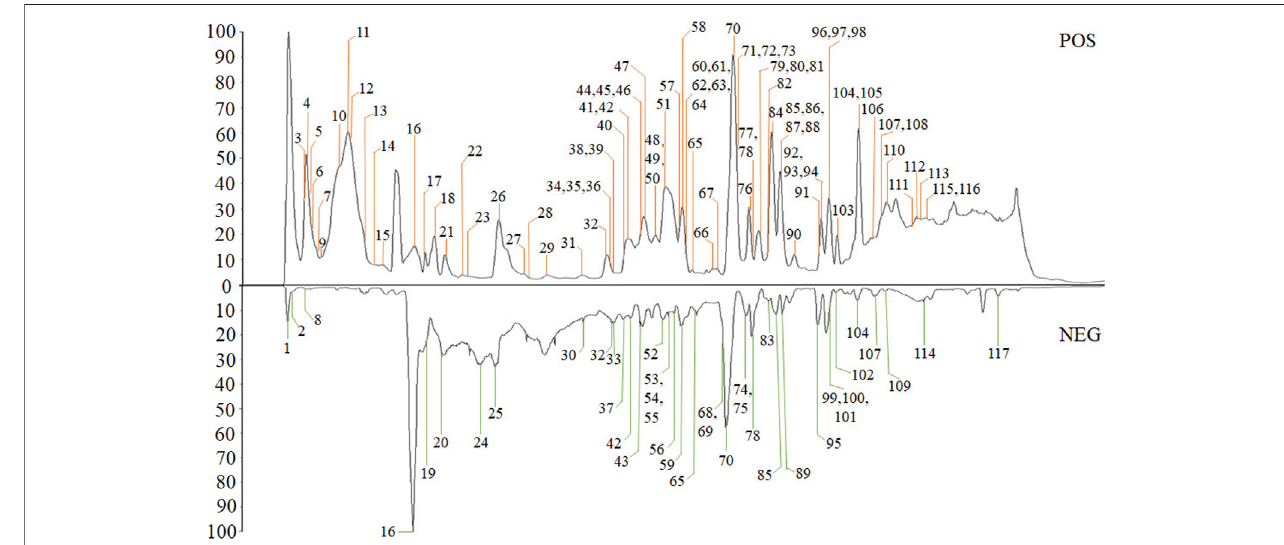
FIGURE 1 | The TIC chromatograms of HJP from UPLC/Q-TOF-MS E